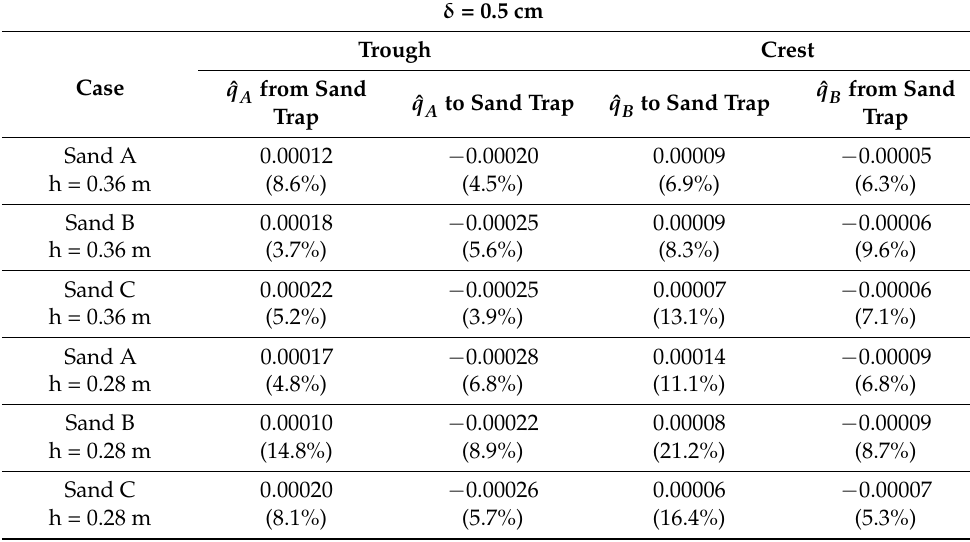
Table 6. PIV estimates of sand